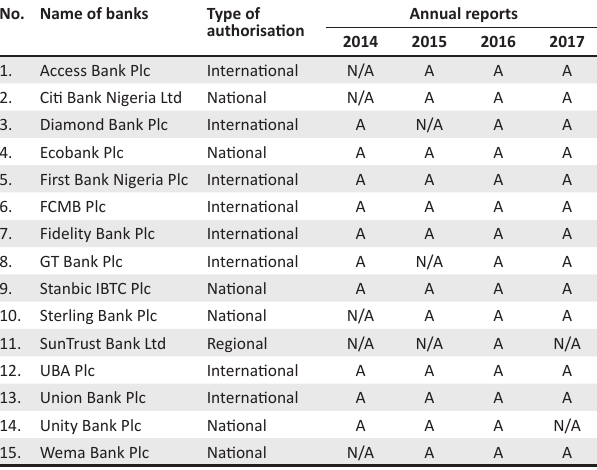
TABLE 2: Name of banks, type of authorisation and years of annual